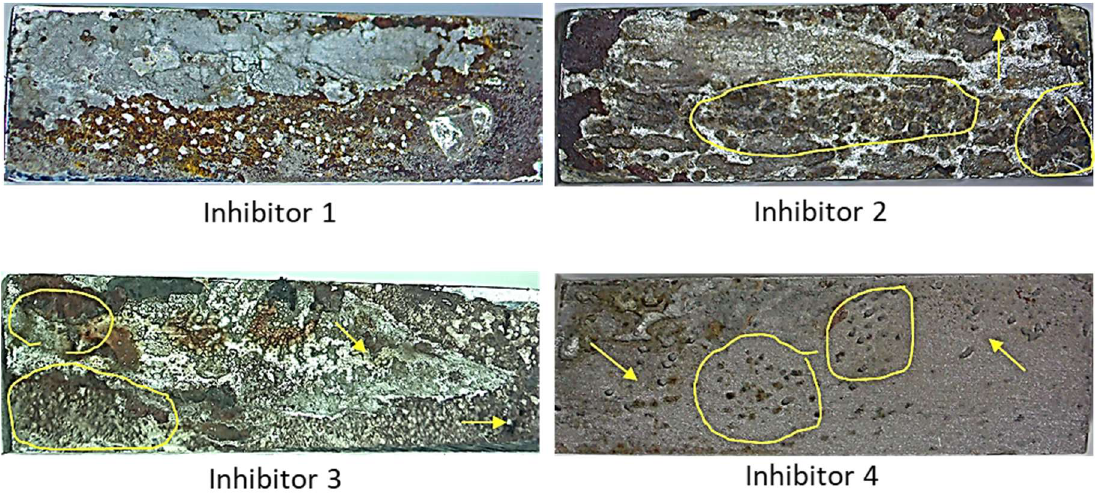
Figure 5. Pictures of the tested samples for each inhibitor. The circles and yellow arrows show the presence of localized corrosion (20×).